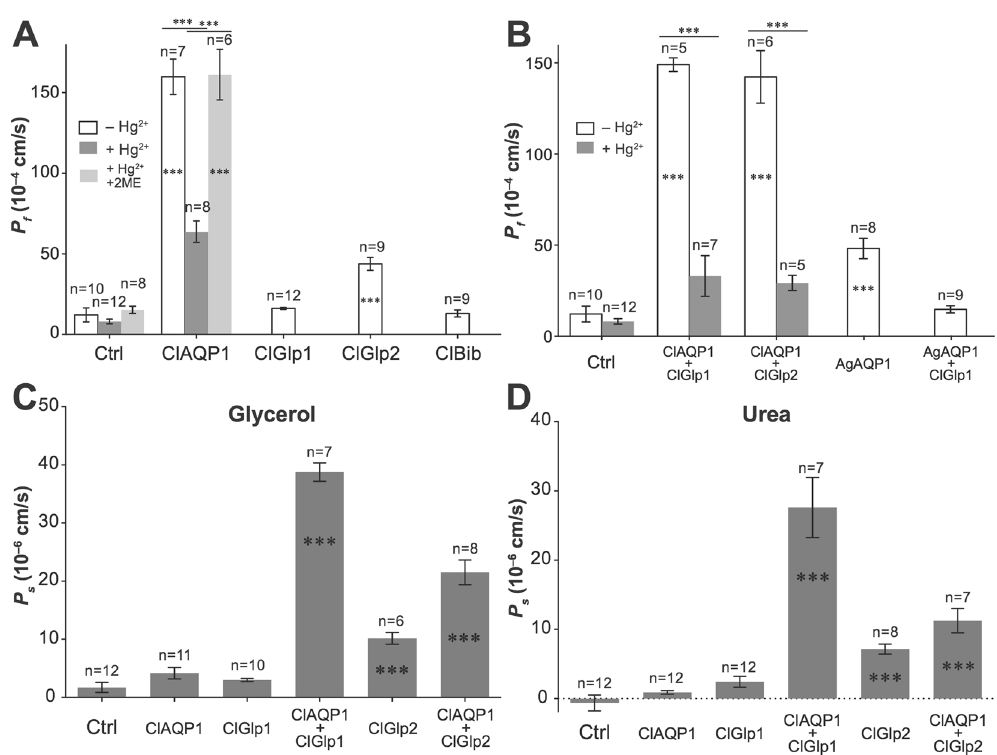
Figure 3. Water and solute transport activity of C . lectularius AQP genes expressed individually in Xenopus oocytes. ( A ) ClAQP1 transports water, and is inhibited by mercury. ClGlp1 and ClBib do not transport water. ClClp2 moderately transports water. ( B ) Water transport ability of ClAQP1 is not altered by co-expression with ClGlps. ( C ) ClGlp1 does not transport glycerol when expressed by itself, but showed high efficiency glycerol transporter activity when co-expressed with ClAQP1. Glycerol transport ability of ClGlp2 is enhanced when co-expressed with ClAQP1. ( D ) ClGlp1 does not transport urea when expressed by itself, but showed high efficiency urea transporter activity when co-expressed with ClAQP1. Urea transport ability of ClGlp2 is enhanced when co-expressed with ClAQP1. The graph shows mean ± SEM. Asterisks in the bars represent statistical significance (P < 0.001) in comparison to control; asterisks above the bars represent statistical significance (P < 0.001) comparing between the groups below the horizontal